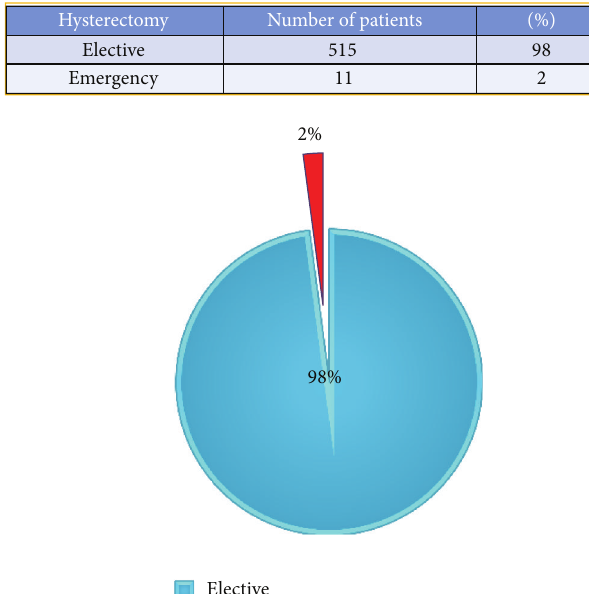
Table 2: Indication of hysterectomy (an overall